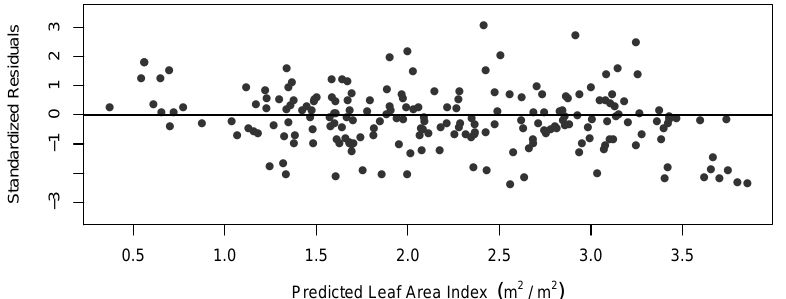
Figure 6. Standardized residuals for predictions using Equation (4). Results show little evidence of heteroscedasticity, indicating good model performance.